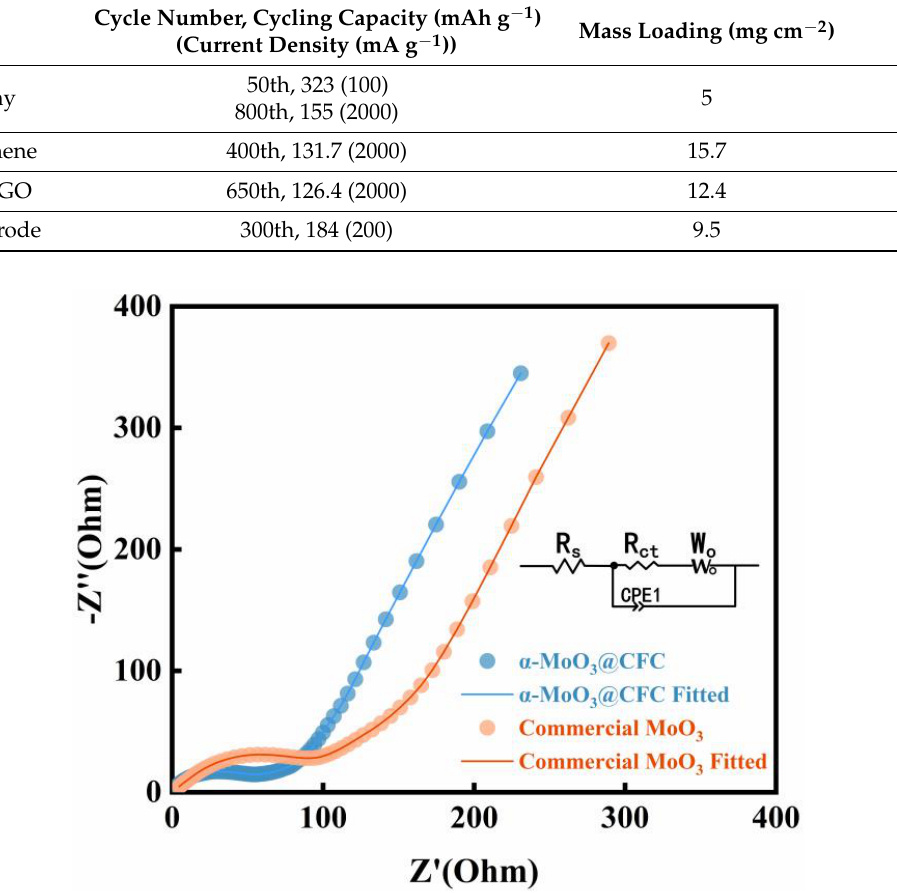
Figure 5. Electrochemical impedance spectroscopy of α -MoO 3 @CFC and commercial MoO 3 .